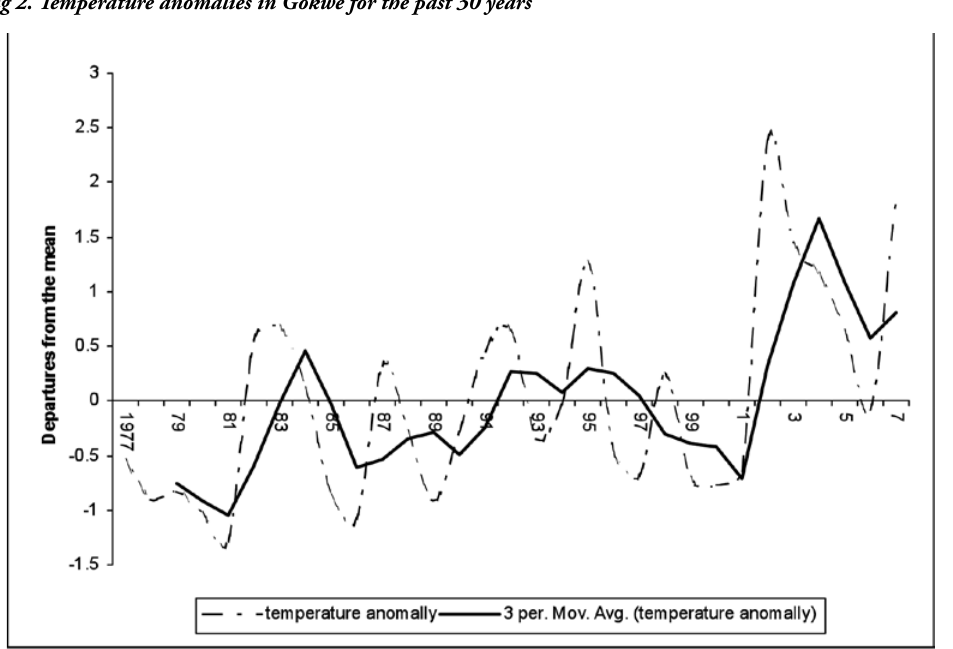
Fig 2. Temperature anomalies in Gokwe for the past 30 years